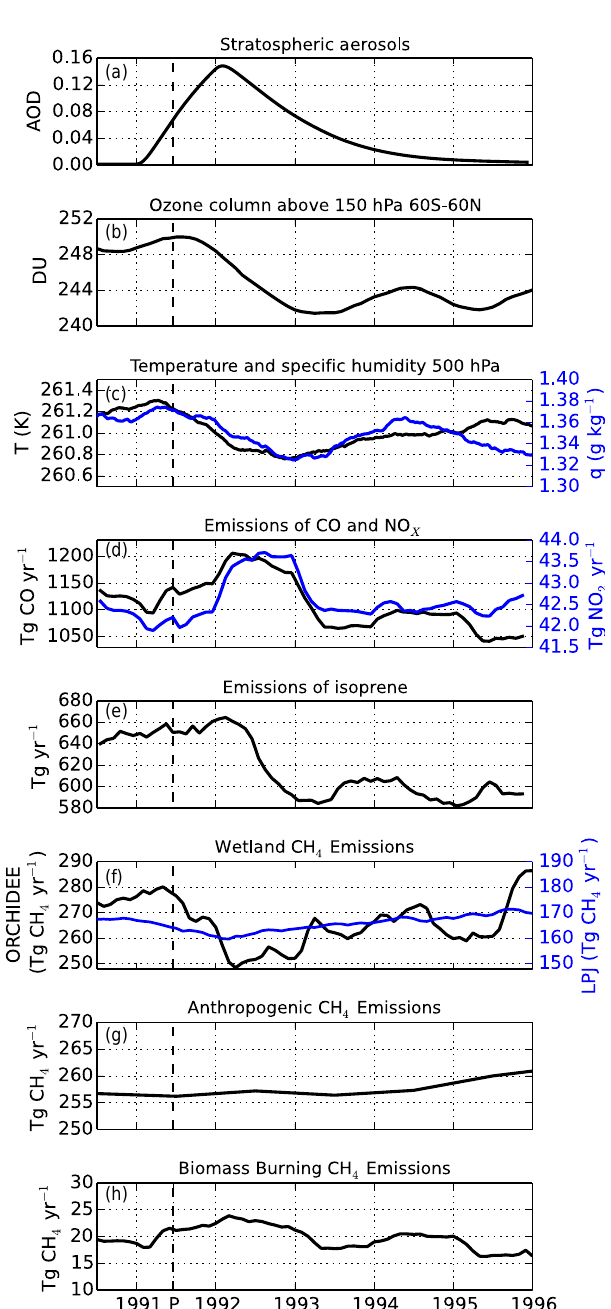
Figure 1. The drivers of CH 4 IAV in the early 1990s considered in this study. The black dashed line denotes the timing of the Pinatubo